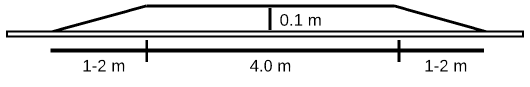
Figure 1. Speed humps length and height with trapezoidal